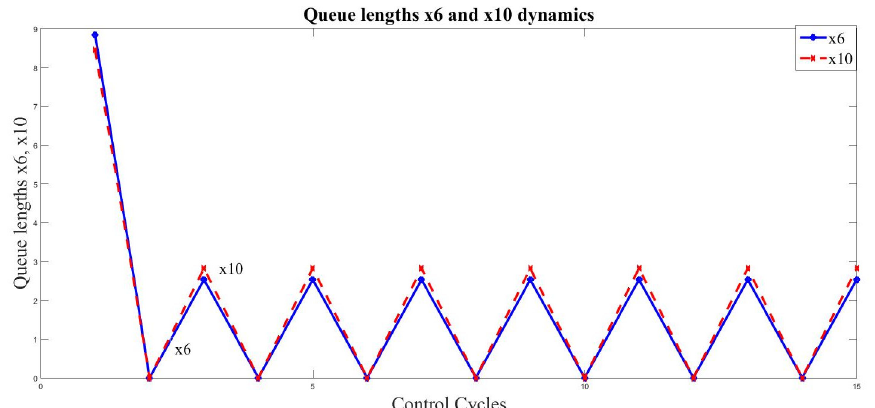
Figure 11. Dynamics of queue lengths x 6 and x 10 .